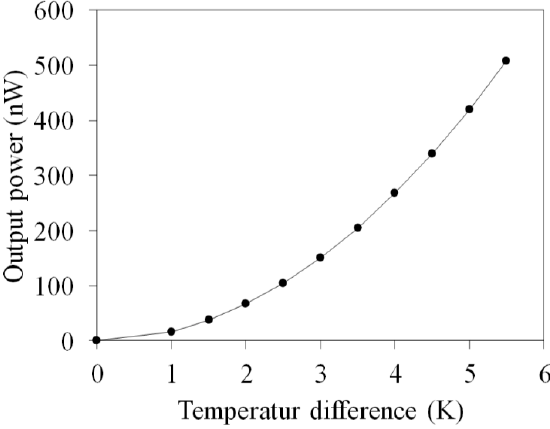
Figure 3. Simulated output power for a flexible thermoelectric generator.